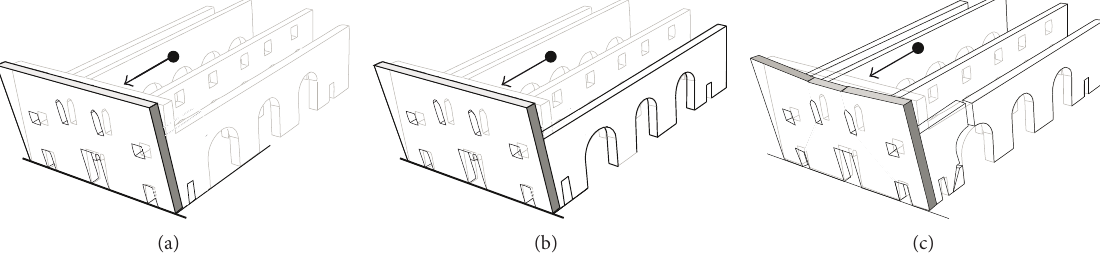
Figure 9: Out-of-plane mechanisms of the fac¸ade macroelement. (a) Mechanism 1: out-of-plane mechanism of the fac¸ade; (b) mechanism 2: interaction between the fac¸ade and the peripheral lateral walls; (c) mechanism 3: interaction between the fac¸ade, the peripheral lateral walls, and the nave walls. Roof structure and surrounding chapels are here hidden to view. Light gray parts in the picture are not part of the